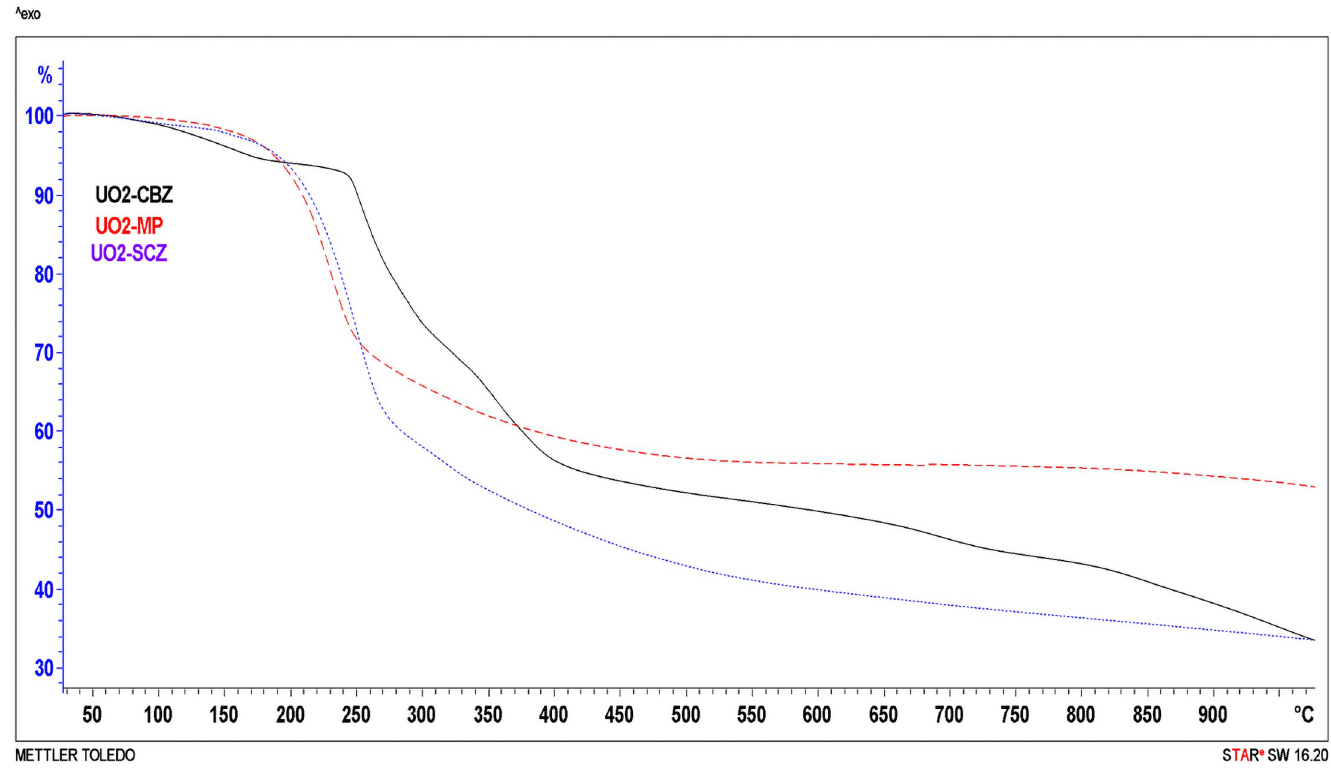
Fig 6. TGA curves for the uranyl complexes in the range